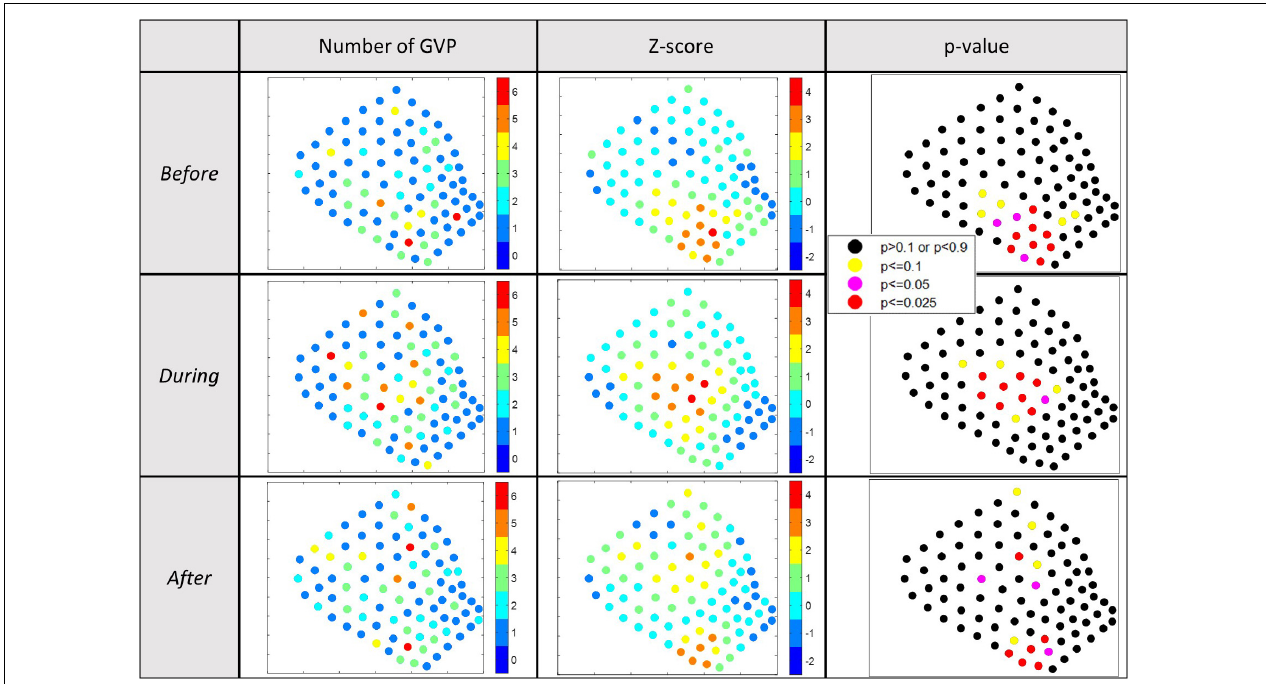
FIGURE 6 | Results of the 2019 Gi* analysis for local hot/cold spots. Column 1: visual depiction of the number of GVPs by hydrophone; column 2: visual depiction of the Gi* z-values by hydrophone; column 3: visual depiction of the p -values associated with the Gi* results by hydrophone. p < 0.025 were considered relative hot spots, whereas p > 0.975 were considered relative cold spots. Each row represents a different analysis period: top- Before ; middle- During ; bottom- After .